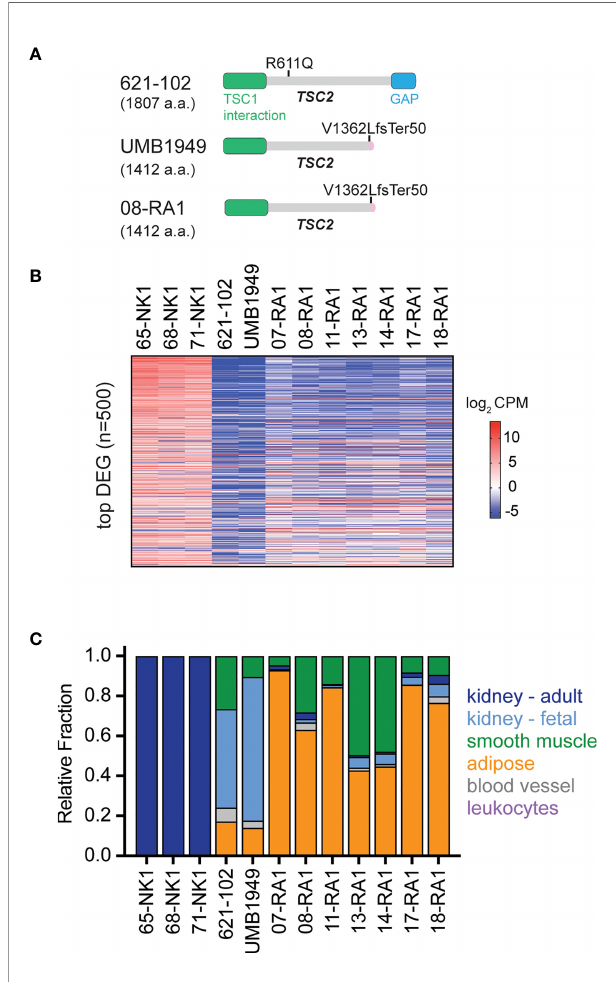
FIGURE 3 | Molecular characterization of TSC cellular models. (A) Schematic for TSC2 protein structure in TSC2-de fi cient cell lines (621-102 and UMB1949) or 08-RA1 patient renal angiolipoma (RA) tumor; GAP, GTPase- activating protein. TSC2 deletion in patient-derived UMB1949 and renal angiomyolipoma 08-RA1. (B) Top 500 most differentially expressed genes (DEG), sorted high (top) to low (bottom) across the indicated samples and colored by log2 CPM according to the indicated scale. (C) The relative fraction of gene signatures estimated by CIBERSORT (gray, blood vessel; green, smooth muscle; orange, adipose; light blue, fetal kidney; dark blue, adult kidney; leukocytes